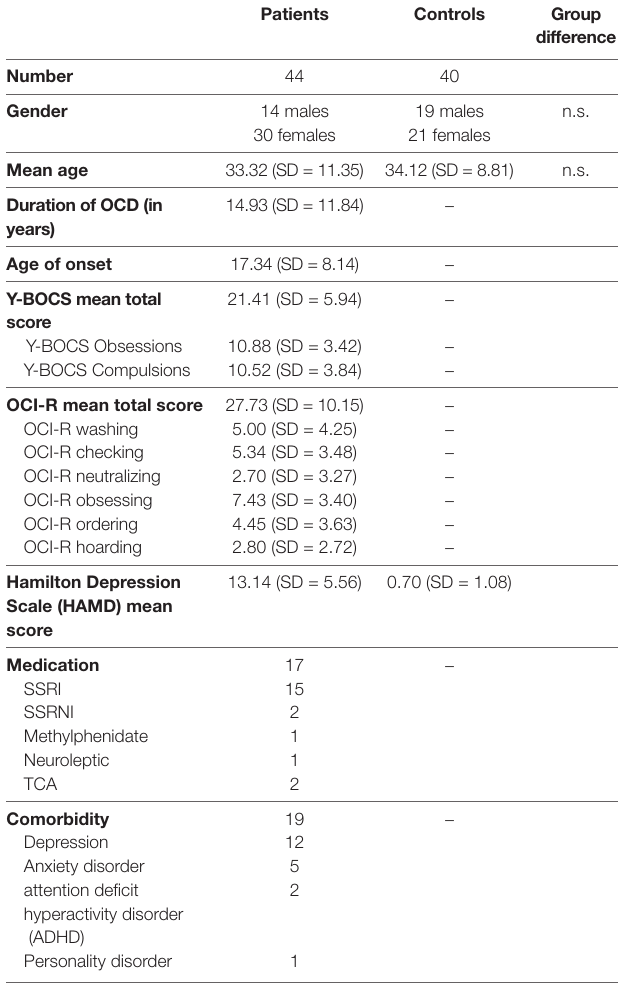
TABLE 1 | Demographic and clinical